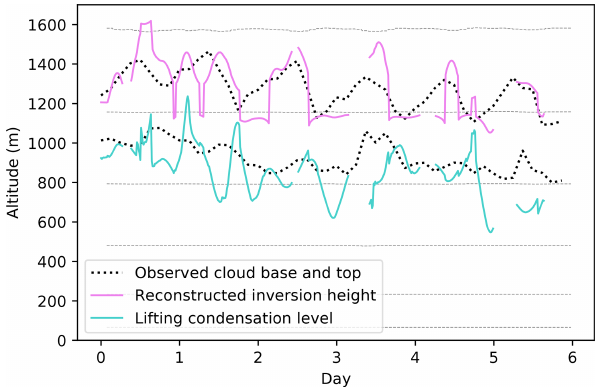
Figure 3. Observed cloud base and top during the stratocumu- lus segment of the EPIC campaign (Bretherton, 2005), and recon- structed inversion and lifting condensation level height. The grey dashed horizontal lines are model half-levels in ECHAM-HAM. The time series starts on 15 October 2001 at 18:00LT. The cloud and its boundaries as represented by the model can be seen in Fig. 5